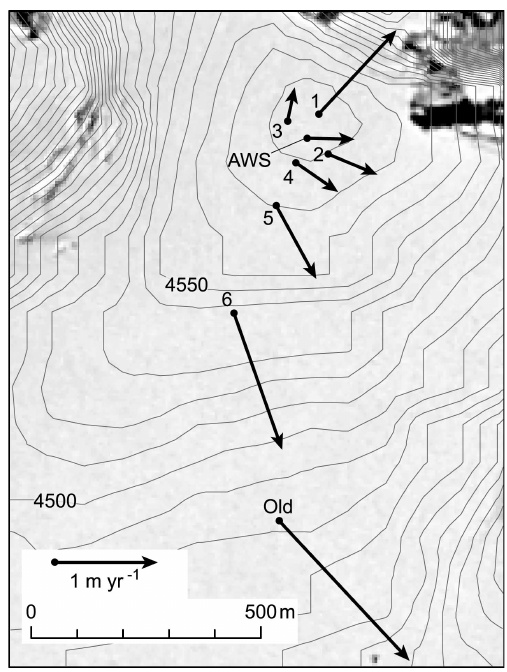
Fig. 3. Surface flow velocities (arrows) measured at stakes (dots) on the Gregoriev Glacier between 2006 and 2007. Contour lines (10-m interval) are drawn based on an SRTM-DEM. The background im- age is a Hexagon KH-9 image taken on 21 August 1980. Values are Table 2. Flow components and change in height of stakes around the summit of the Gregoriev Glacier for 2006 and 2007 (except AWS, which was also measured in 2005). dH, dSF, dSA and dVD denote changes in the horizontal position of the stake, verti- cal change in the glacier surface, snow accumulation obtained from the stake height, and vertical lowering by glacier flow, respectively. The horizontal flow directions are shown in Fig.